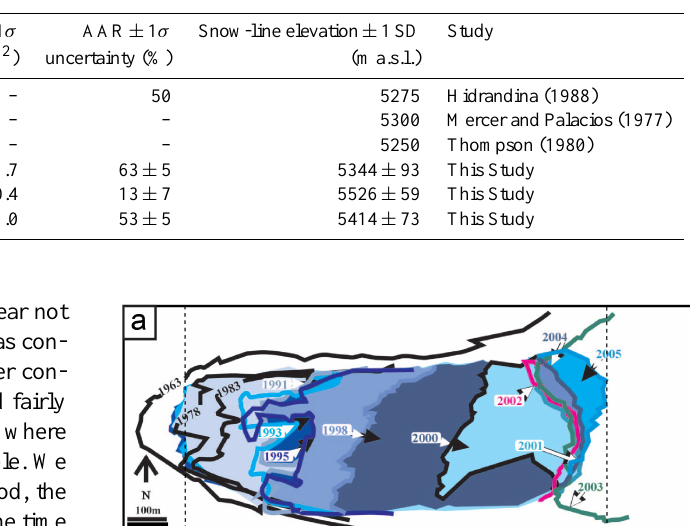
Table 4. Glacial area, accumulation area, AAR (accumulation area ratio), and snow-line elevation for the QIC as reported in this and previous studies.